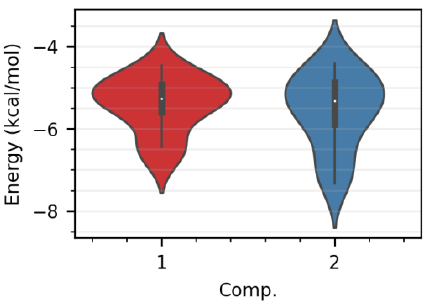
Figure 3. Distribution of the binding energies of horminone – 7-acetoxyhorminone ( 1 ) and 7-acetoxyhorminone ( 2 ).